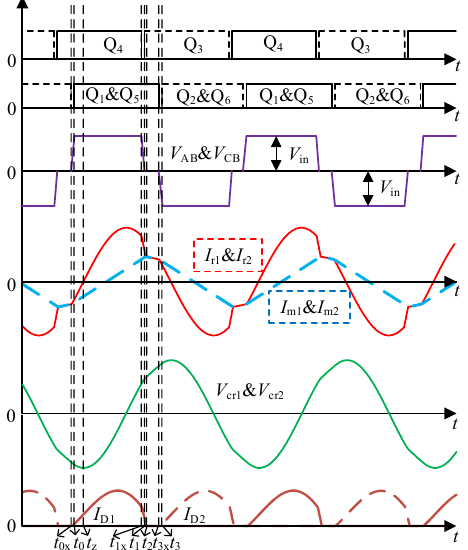
Figure 5. Main working waveform diagram of full ‐ bridge phase ‐ shift mode.